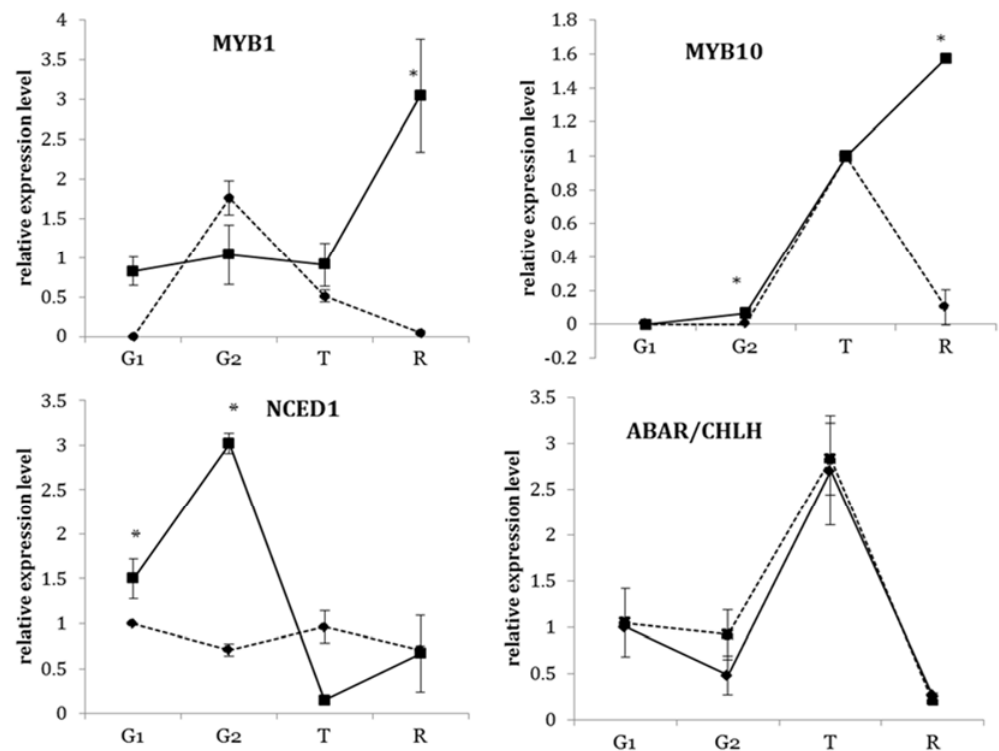
Figure 3. Transcript abundance of the key transcription factors, MYB1 and MYB10, and of the abscisic acid biosynthesis and receptor genes, NCED1 and ABAR/CHLH, respectively, during development and ripening of the Fragaria vesca cultivars, Baron Solemacher (solid line) and Pineapple Crush (dashed line) with red and white fruit, respectively, by qRT-PCR. Developmental stages are: G1 = early green with no spacing between achenes, G2 = intermediate green with spacing between achenes and green receptacle showing, T = turning with the receptacle becoming pinkish-white for BS and white for PC, and R = ripe with a soft red receptacle for BS and soft white receptacle for PC. Data represented are the mean of three individual experiments with error bars indicating ± SD. Asterisks indicate a significant difference as determined by Student’s t -test ( p < 0.05).